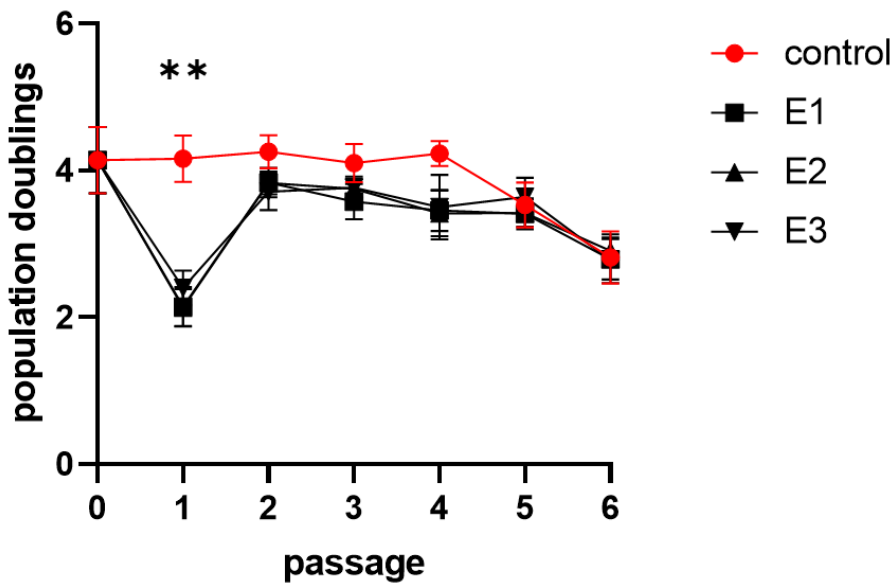
Figure 4. Population doublings during the cultivation. The graph demonstrates population doublings of dental pulp stem cells as a mean of cell lines 1–5 with SEM plotted as error bars in experimental passages. Cells were cultivated in the control (control) and experimental media 1–3 (E1–3). Statistical analysis was performed using Friedman’s test followed by Dunn’s post hoc test; ** p < 0.005. Individual graphs for each cell line are enclosed in supplementary data as Figure S2. Total population doublings achieved: Line 1: 23.2/22.1/21.2/22.8; line 2: